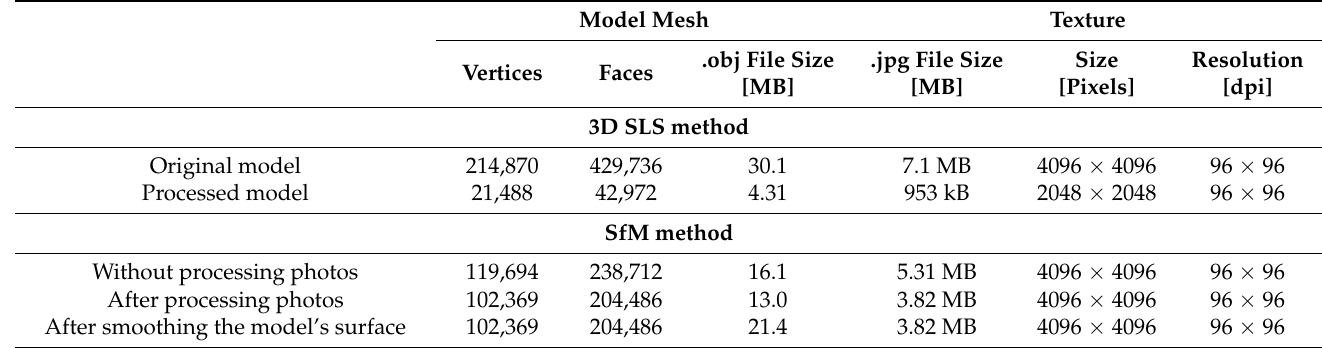
Figure 7. The appearance of a digital 3D model of a jug with 3D SLS: ( a , b ) primary model—without